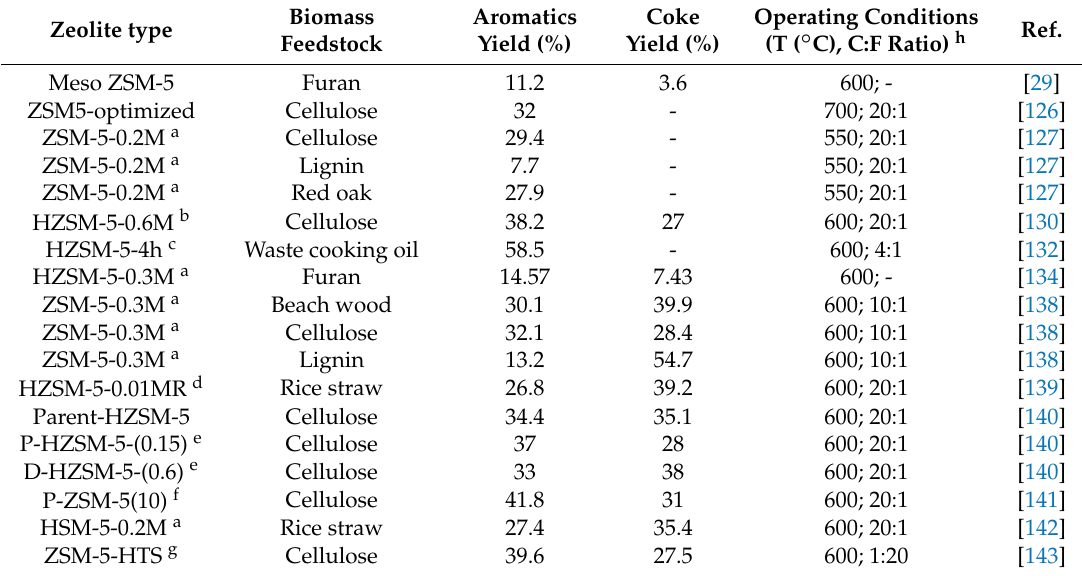
Table 1. Summary of performance of hierarchical zeolites for catalytic biomass